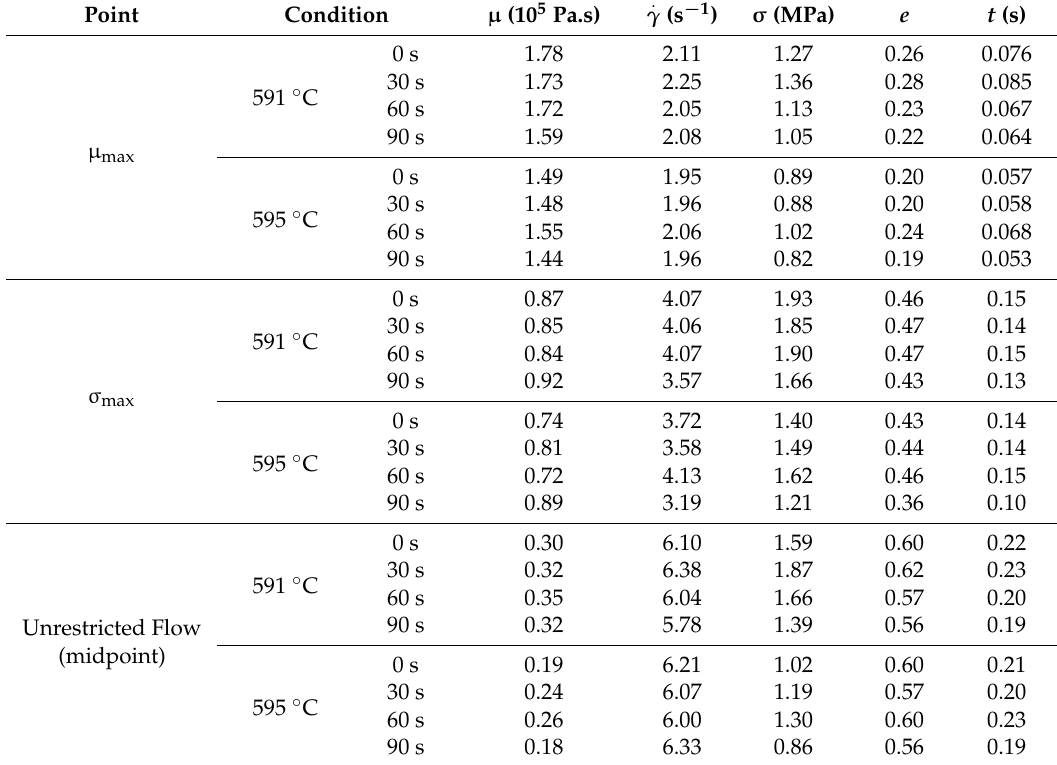
Table 7. Rheological parameters at the point of maximum apparent viscosity (beginning of dendritic breakdown) and point of maximum stress (end of dendritic breakdown) and in the unrestricted flow region (representative point) for heat-treated samples of B319+Fe alloy during thixoforming. Point Condition µ (10 5